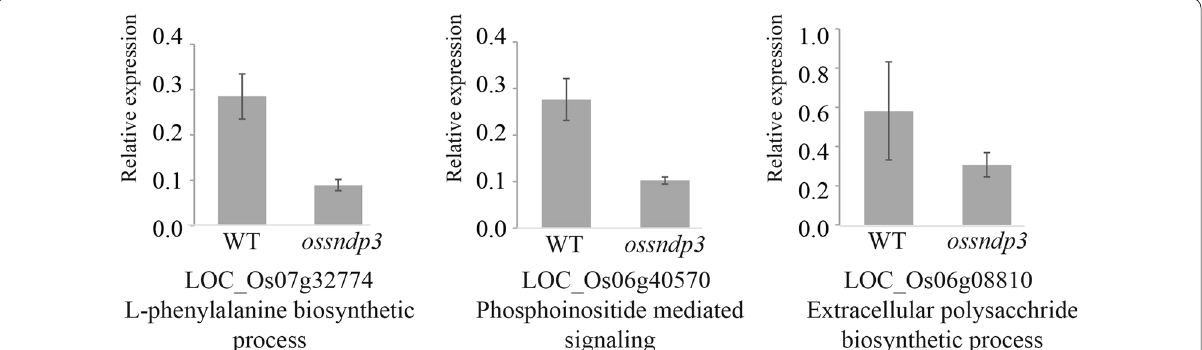
Fig. 6 Real‑time RT‑qPCR analysis of 3 genes downregulated in ossndp3. The relative Expression level of LOC_Os07g32774 , LOC_Os06g40570, and LOC_Os06g08810 in mature anthers of wild type and